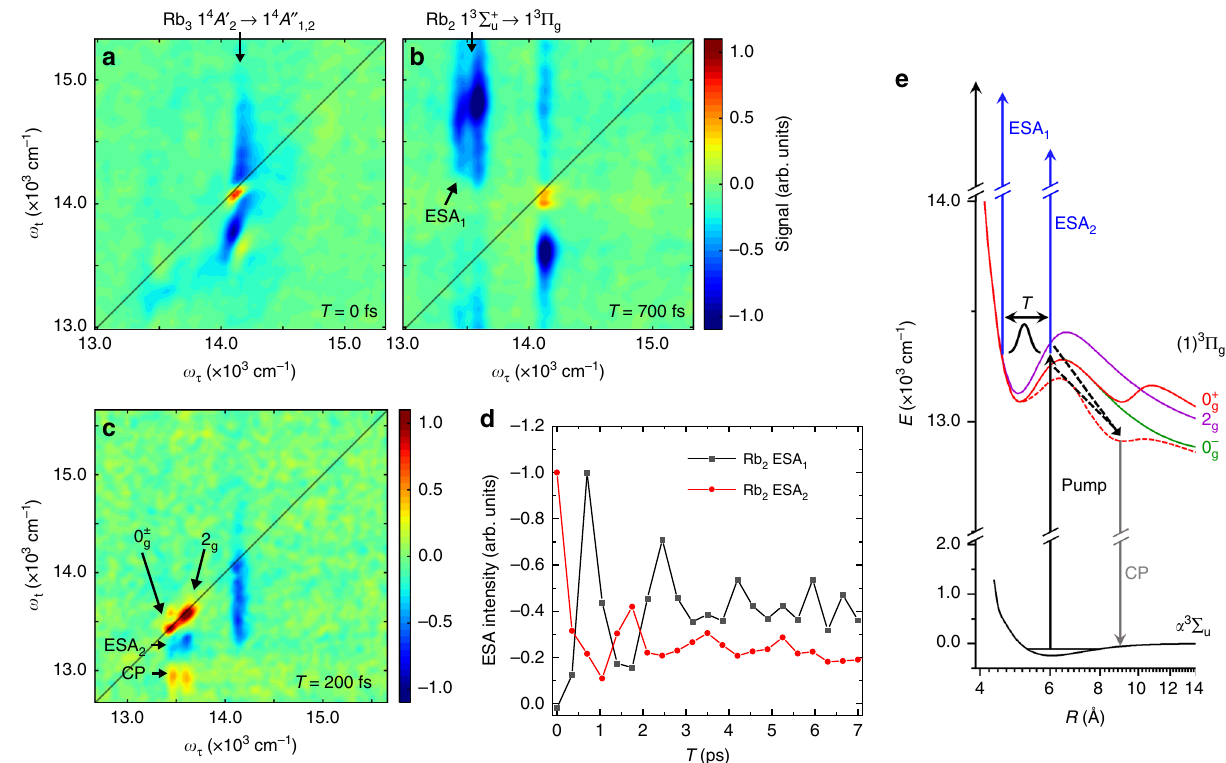
Fig. 2 Rb 2 and Rb 3 2DES results. a , b Photoelectron-2D correlation spectra of isolated Rb 2 and Rb 3 molecules for evolution times T = 0 fs and 700 fs, respectively. Labels indicate the assigned transitions. c Selective enhancement of Rb 2 features using a wavelength-optimized fi fth pulse combined with photoion detection. d Coherent oscillation of Rb 2 excited state absorption (ESA) peaks as a function of T . e Rb 2 PECs 28 and concluded photo dynamics. Transitions are labeled in accordance to b , c . A droplet-induced blue shift of 115 cm − 1 is applied to the 1 ð Þ 3 Π perturbation on the 0 þ state is schematically indicated as dashed g